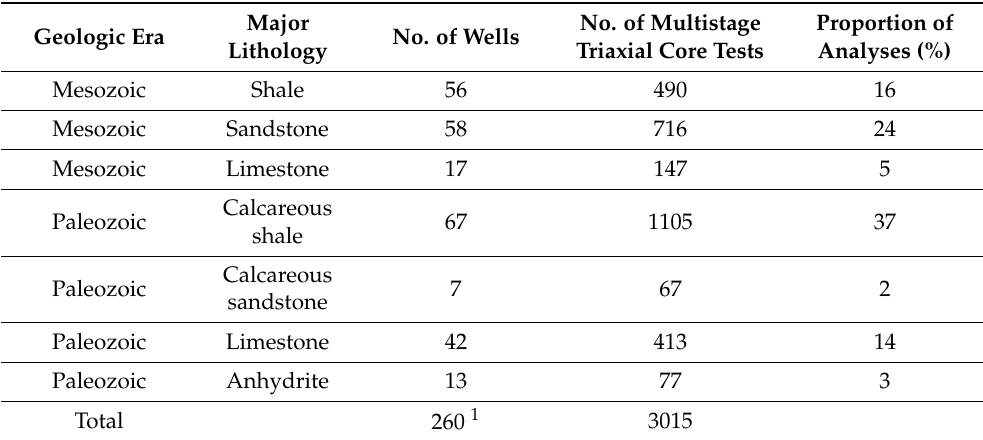
Table 1. Summary of the number of multistage triaxial tests used in this analysis and the source lithologies.